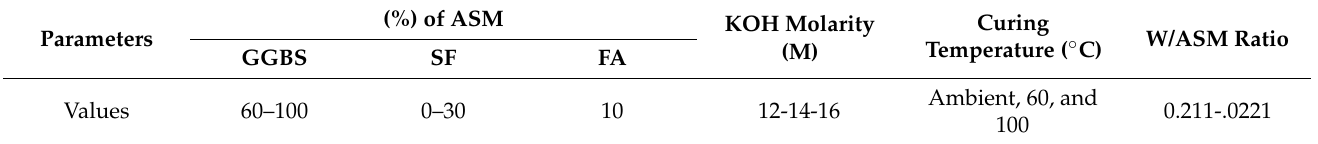
Table 2. The parameters used for control of early compressive strength